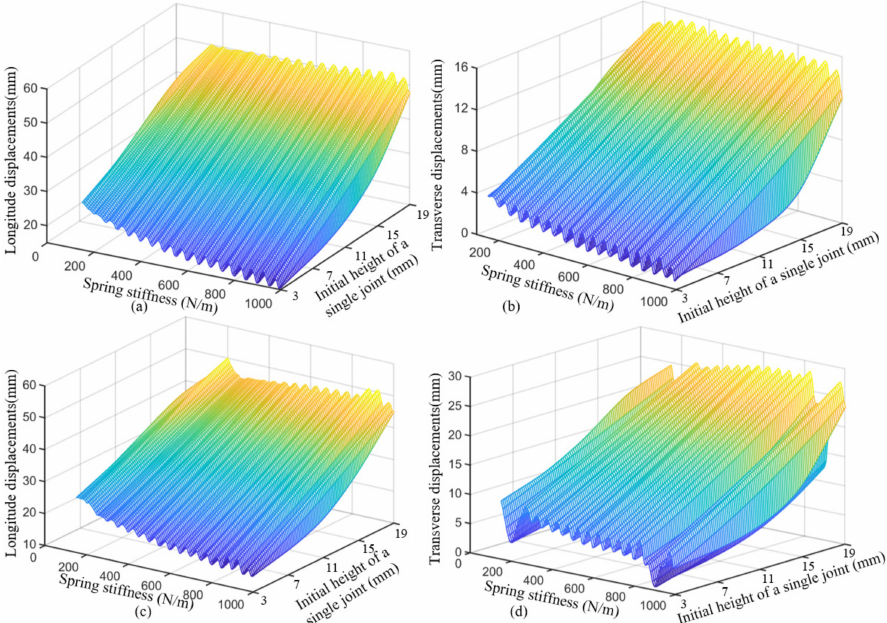
Figure 18. The longitudinal and transverse displacements of the end under different spring stiffness and initial joint heights. ( a ) The relationship among the longitude displacements and spring stiffness and initial height single joint in the initial configuration of the distal segment. ( b ) The relationship among the transverse displacement and spring stiffness and initial height single joint in the initial configuration of the distal segment. ( c ) The relationship among the longitude displacements and spring stiffness and initial height single joint in the bending configuration of the distal segment. ( d ) The relationship among the transverse displacement and spring stiffness and initial height single joint in the bending configuration of the distal